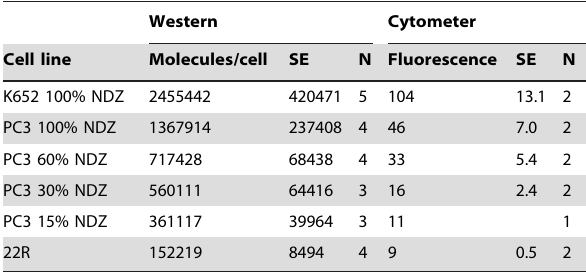
Table 1. Standard Curve.